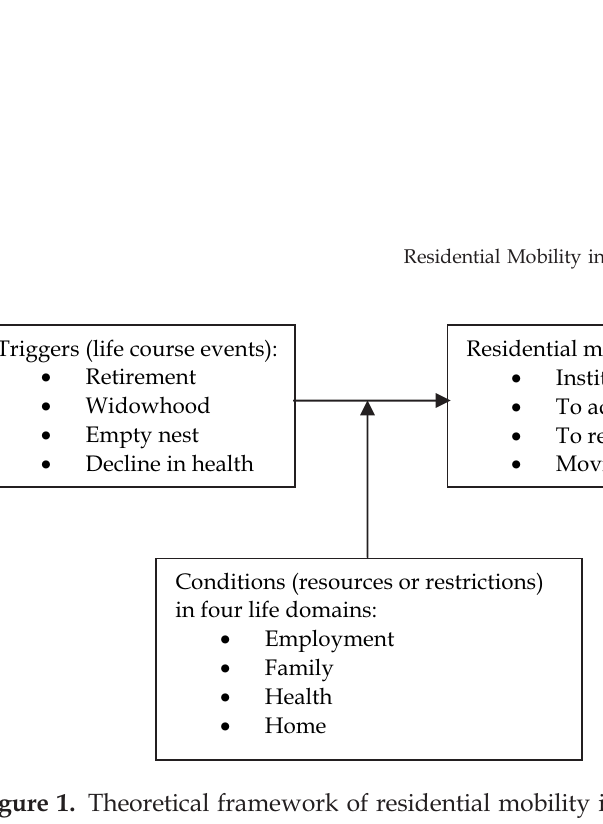
Figure 1. Theoretical framework of residential mobility in the life